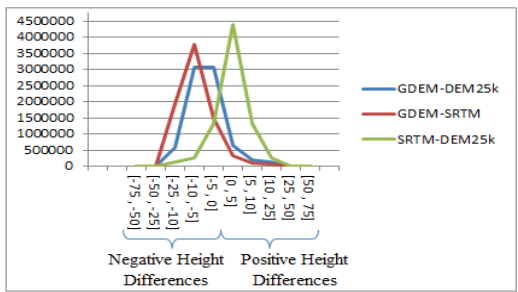
Figure 7. The pixel numbers of images in height differences class intervals for three